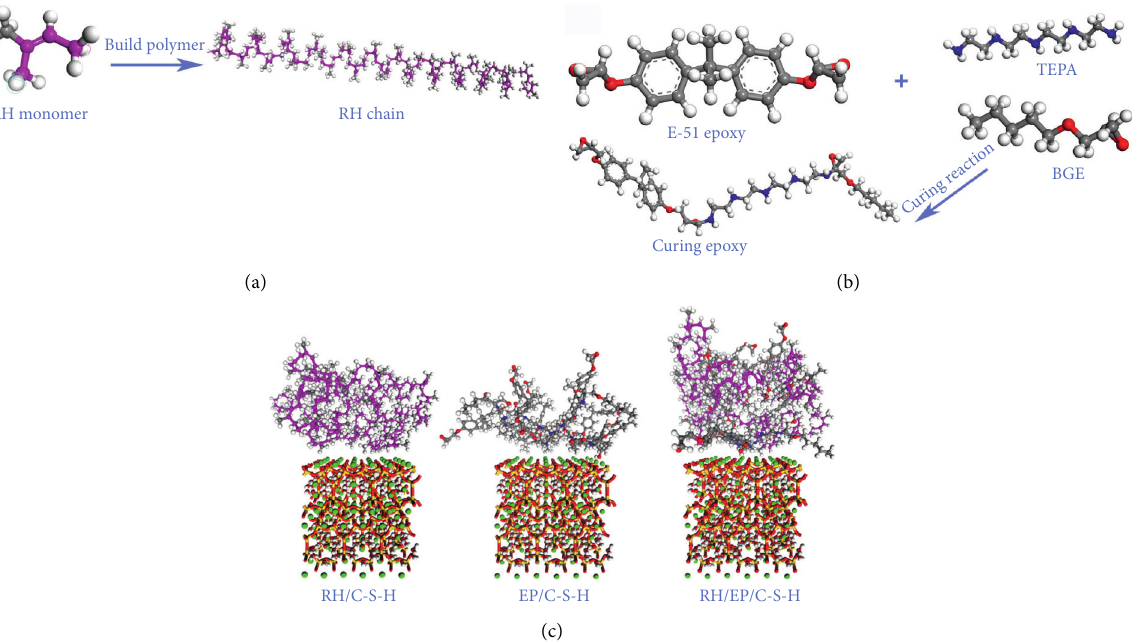
Figure 3: (a) Construction of Rh, (b) construction of EP, and (c) construction of three interface models (pink: carbon chain; white: H; red: O; blue: N; green: Ca; yellow: Si).